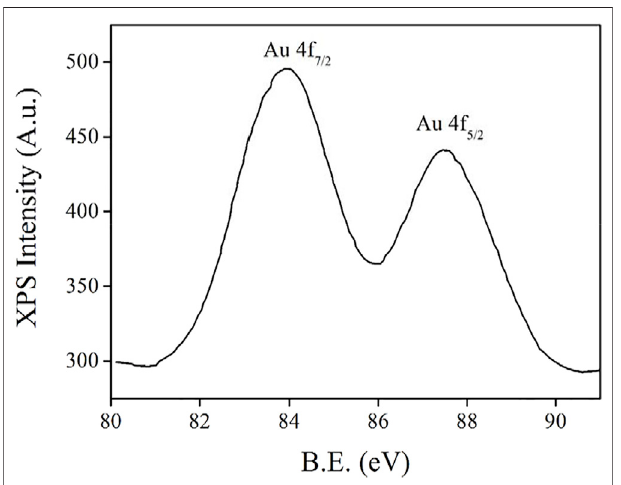
FIGURE 2 | XPS spectrum of the AuNCs.